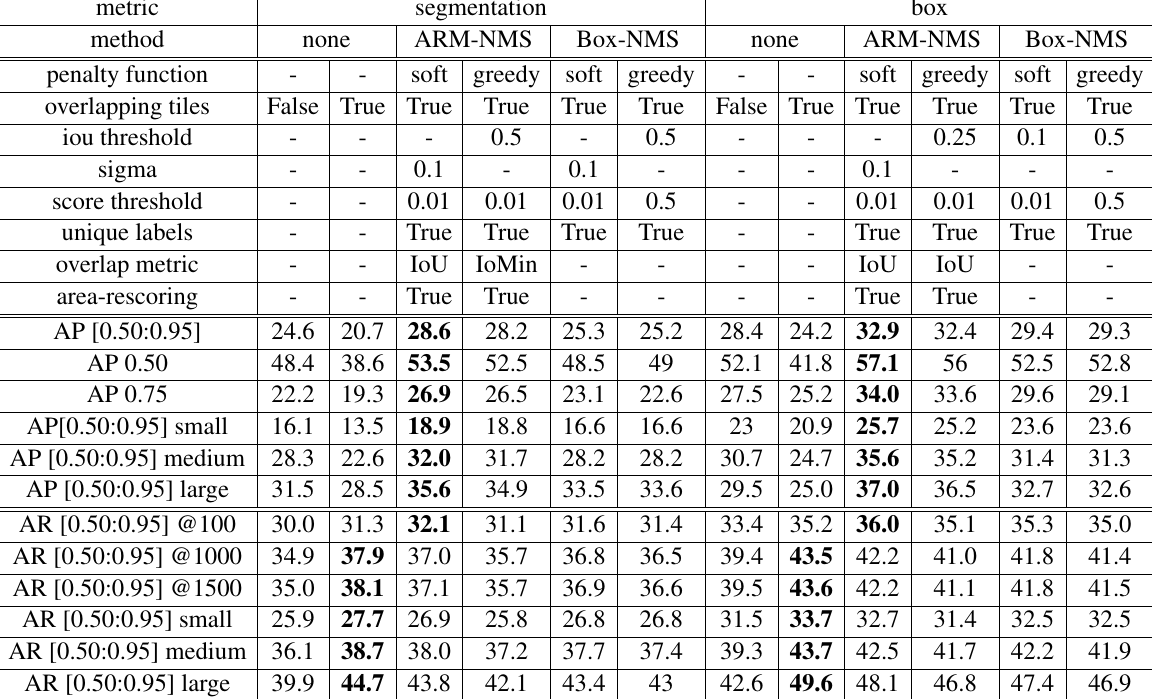
Table 3. NMS Results on the iSaid dataset. We compare our proposed shape-based ARM-NMS with box-based NMS.